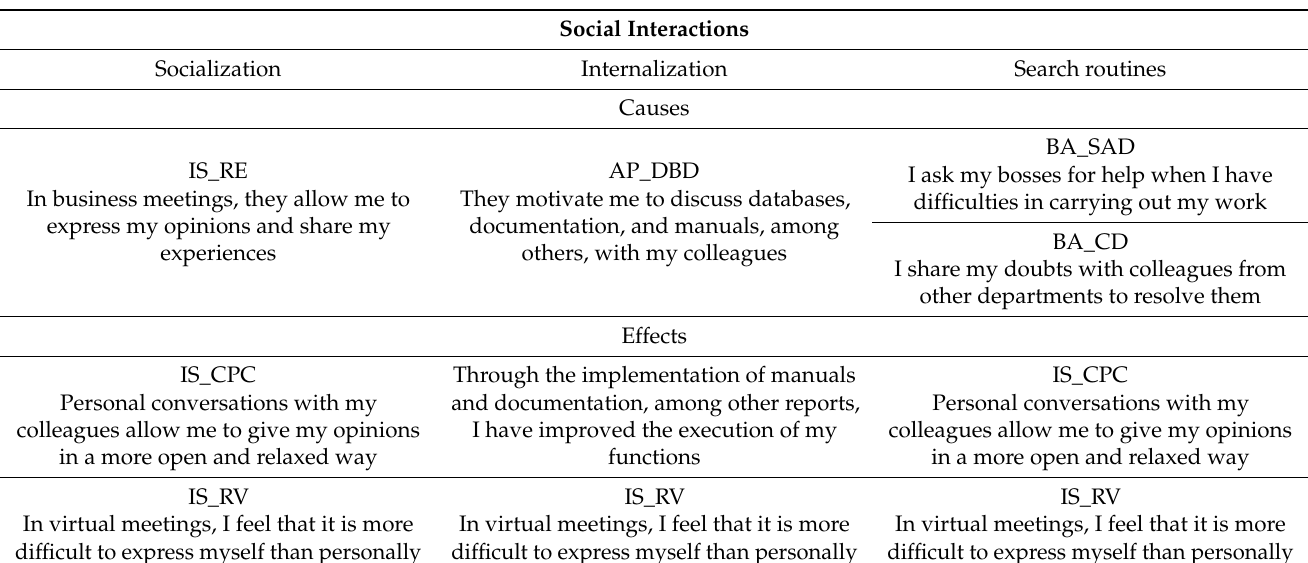
Table 13. Alternate routes of social